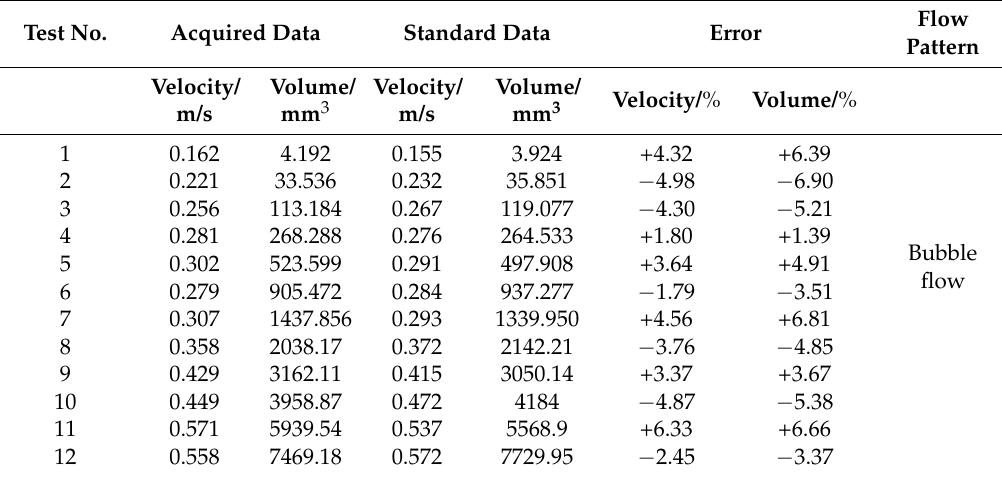
Table 2. Comparison of the test results and normal